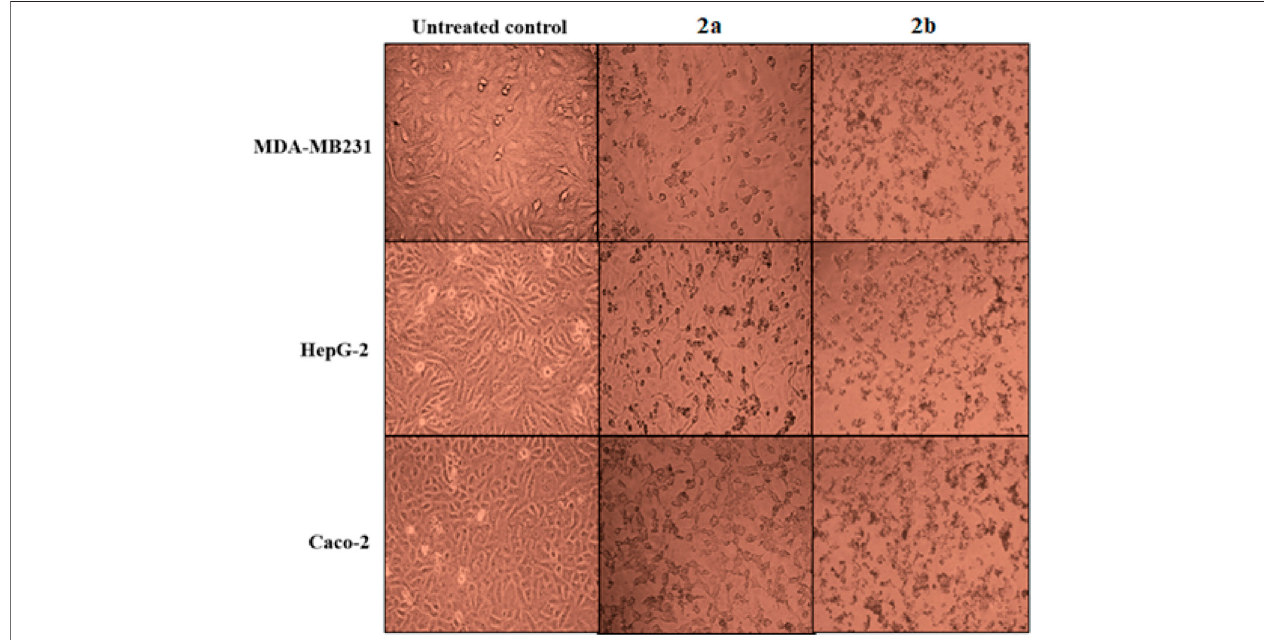
FIGURE 10 | Morphological alterations of 2a- and 2b -treated MDA-MB 231, HepG-2, and Caco-2 cells.